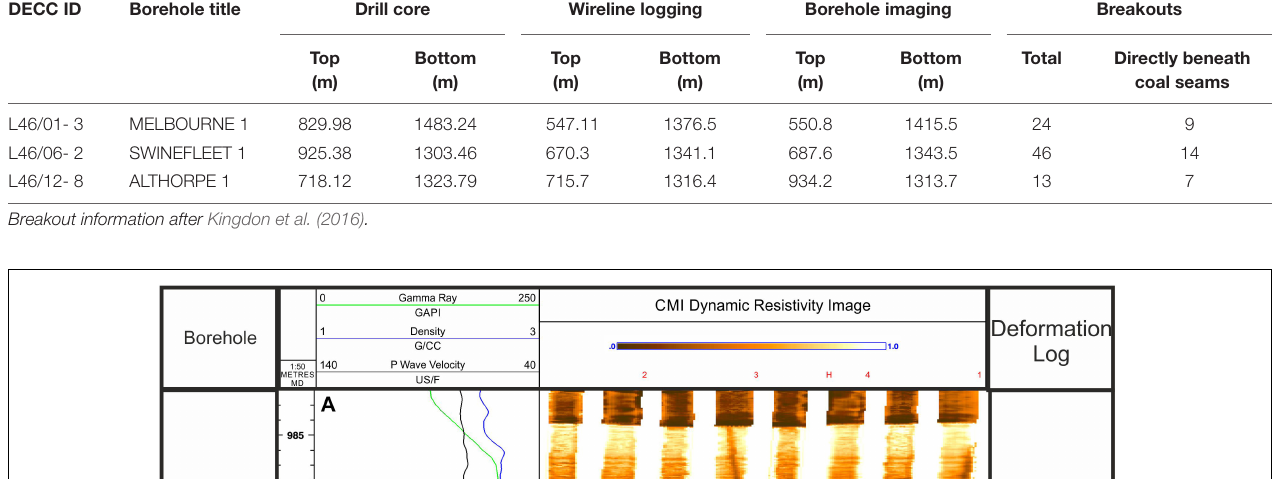
Frontiers in Earth Science |